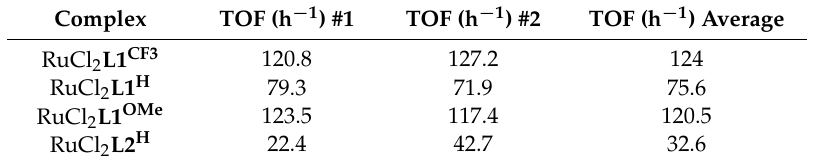
Table 5. Duplo measurements for formic acid dehydrogenation by the depicted catalysts. Complex